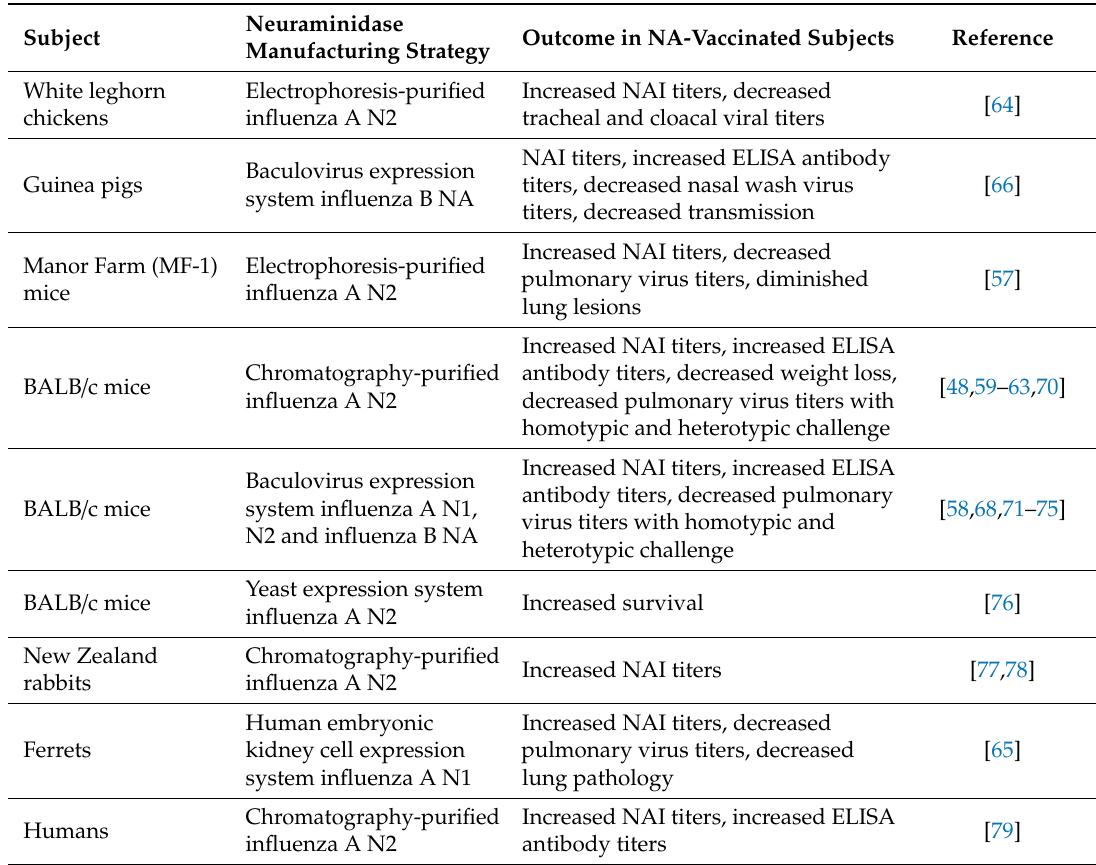
Table 1. Neuraminidase (NA) vaccine outcomes by species and production